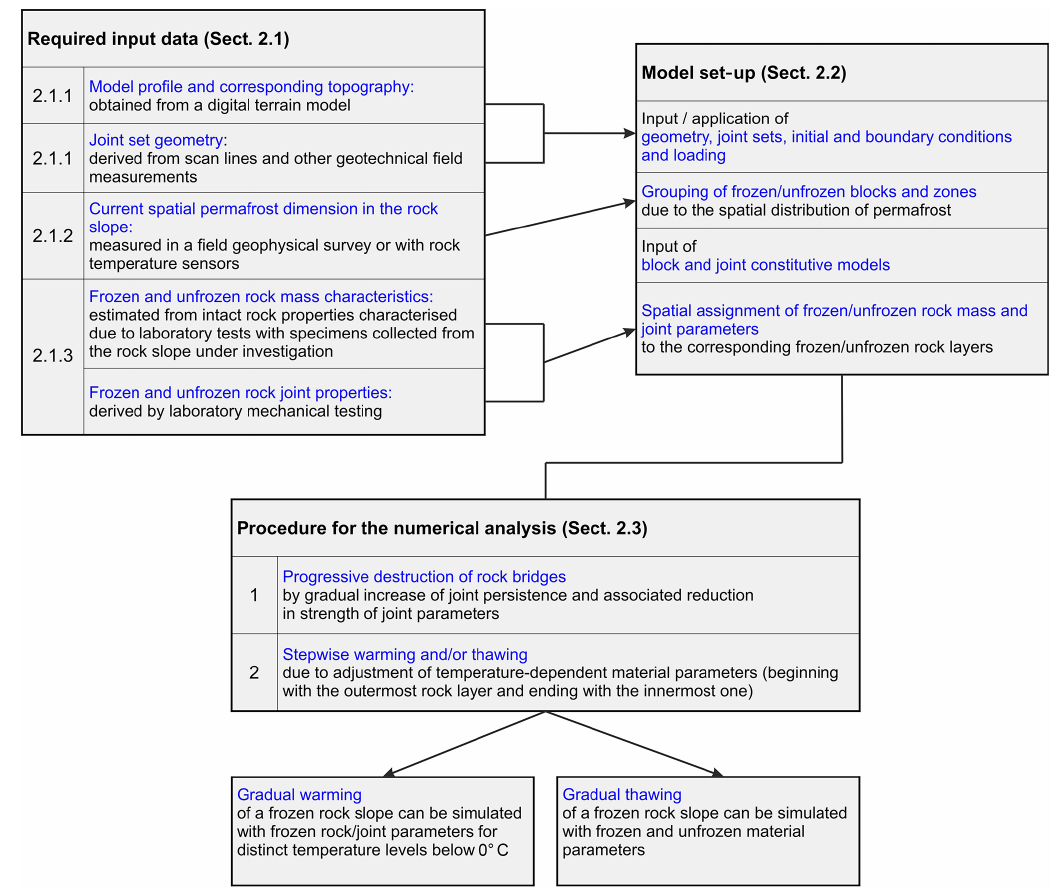
Figure 2. General procedure for a temperature-dependent mechanical discontinuum model for the stability of a warming or thawing per- mafrost rock slope. The procedure is embedded as a methodological approach in this paper and, hence, is linked to specific sections. Table 2. Geotechnical characteristics of the joint